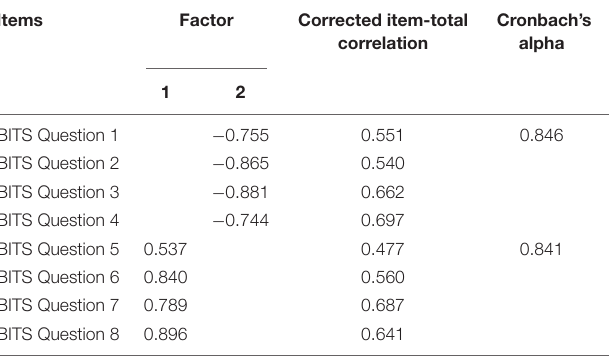
TABLE 3 | Factor loadings, corrected item-total correlation, and Cronbach’s